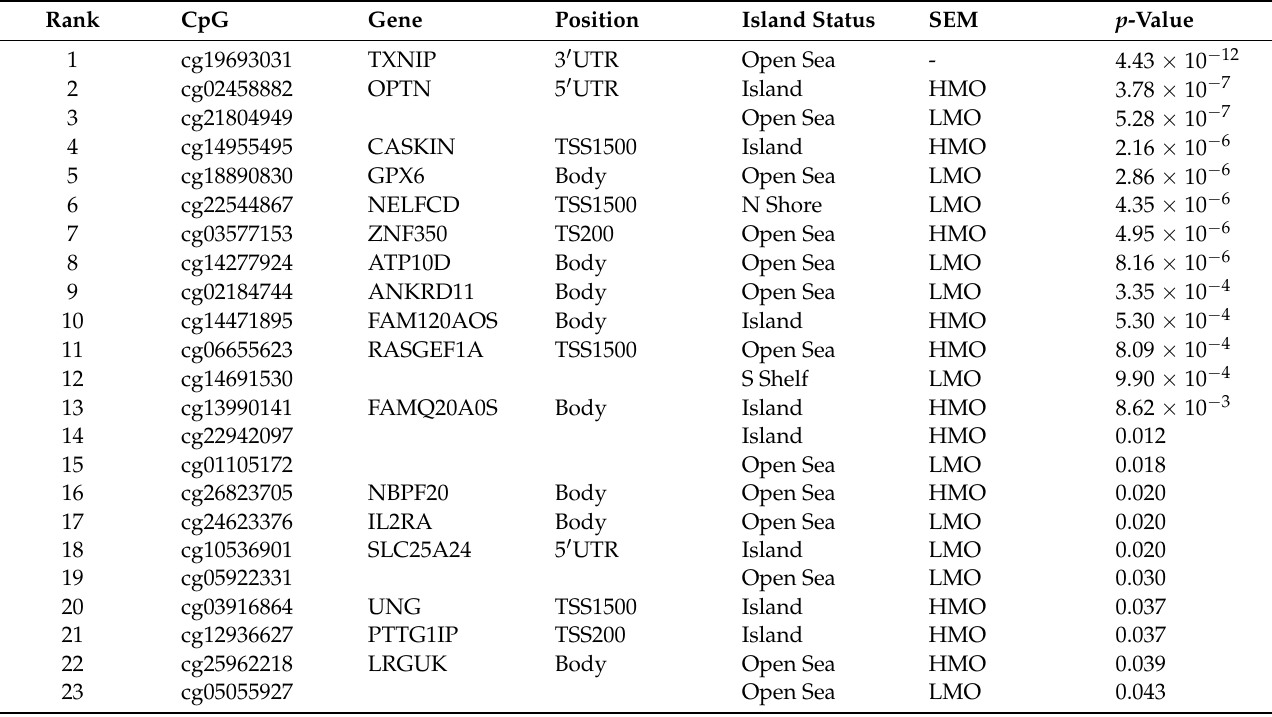
Table 2. Top 21 ranked HbA1c-associated DNAm